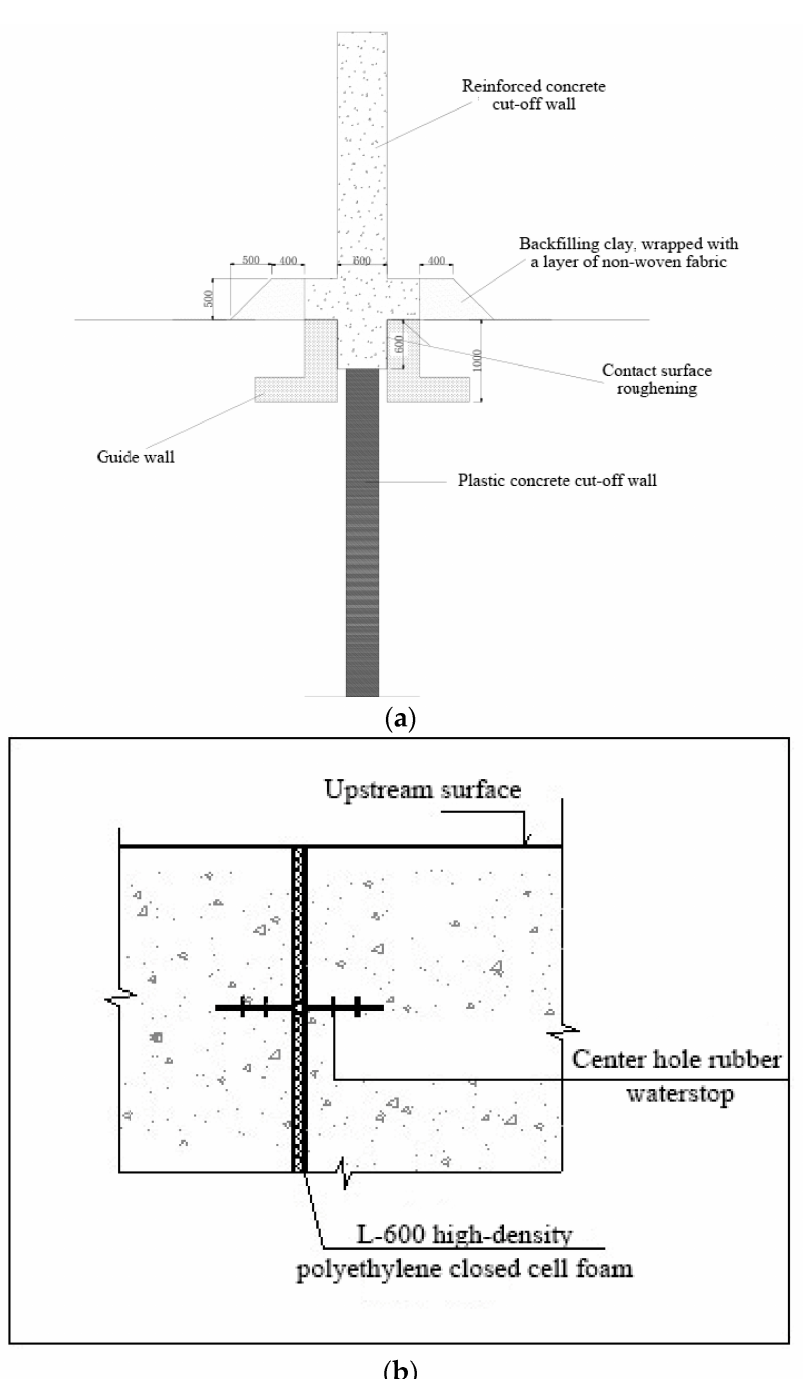
Figure 2. Schematic diagram of the cut-off wall structure. ( a ) Schematic diagram of the interface between reinforced concrete wall and plastic concrete wall. ( b ) Schematic diagram of joints between rigid cut-off